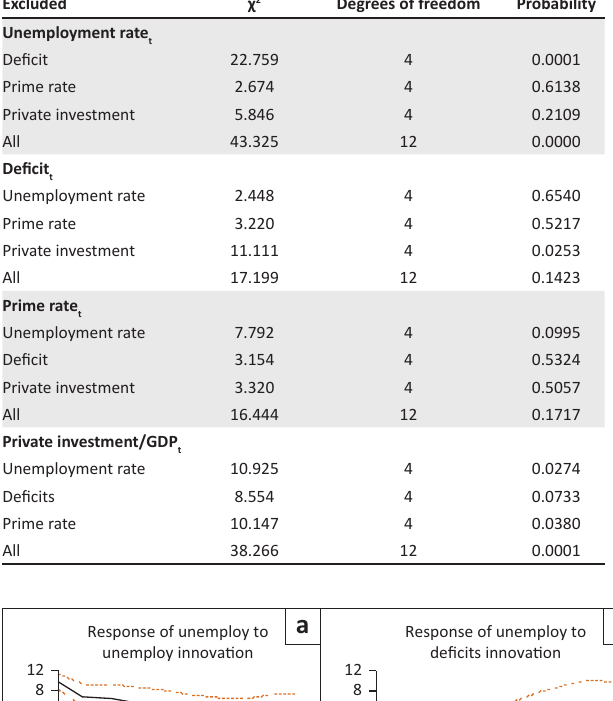
TABLE 3: Vector autoregressive regression Granger causality/block exogeneity Wald